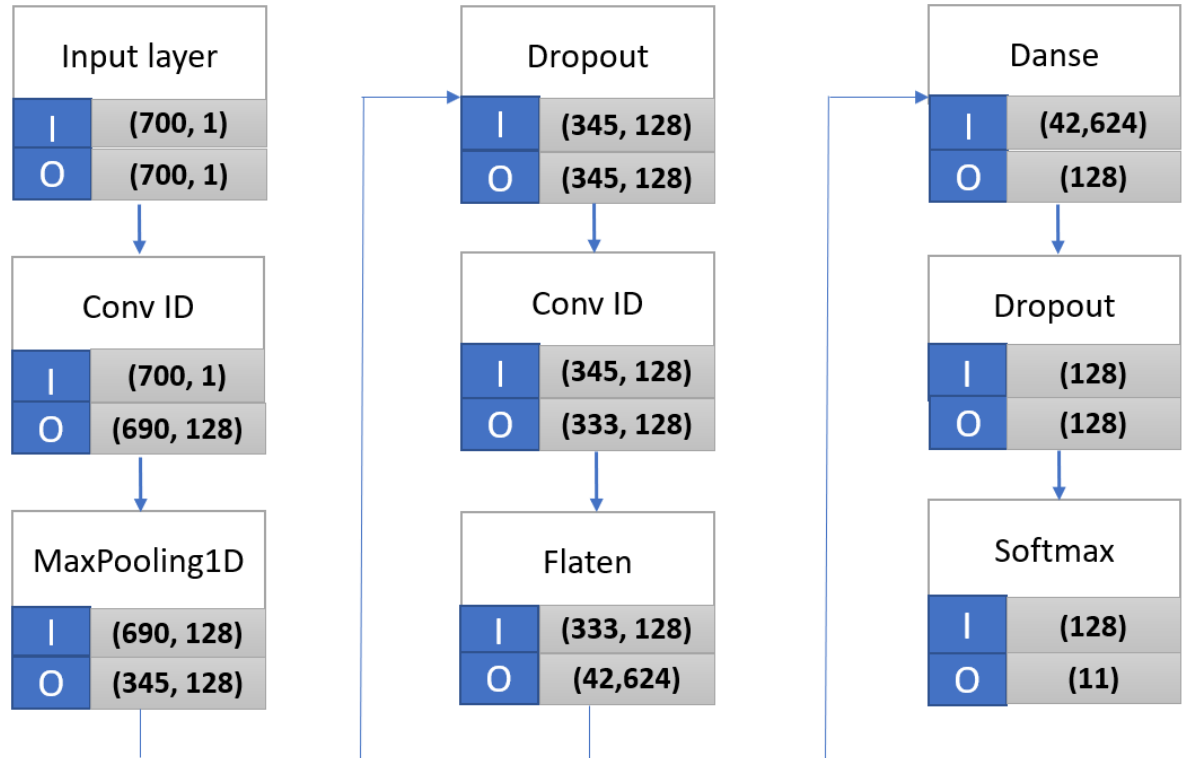
Figure 4. 1D-CNN Architecture. ECG signals 10 MI and Normal class with 700 samples are input into this model layer. They pass through hierarchically arranged convolution layers and turn into feature